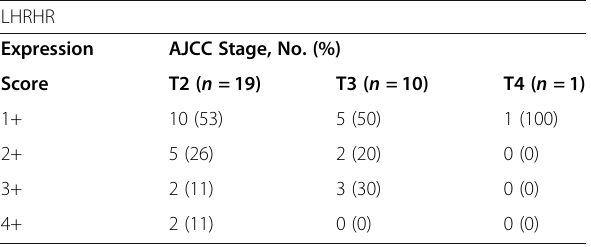
Table 2 Distribution of LHRHR-Positive Urothelial Carcinoma Cases in Relation to AJCC Staging ( n =30)